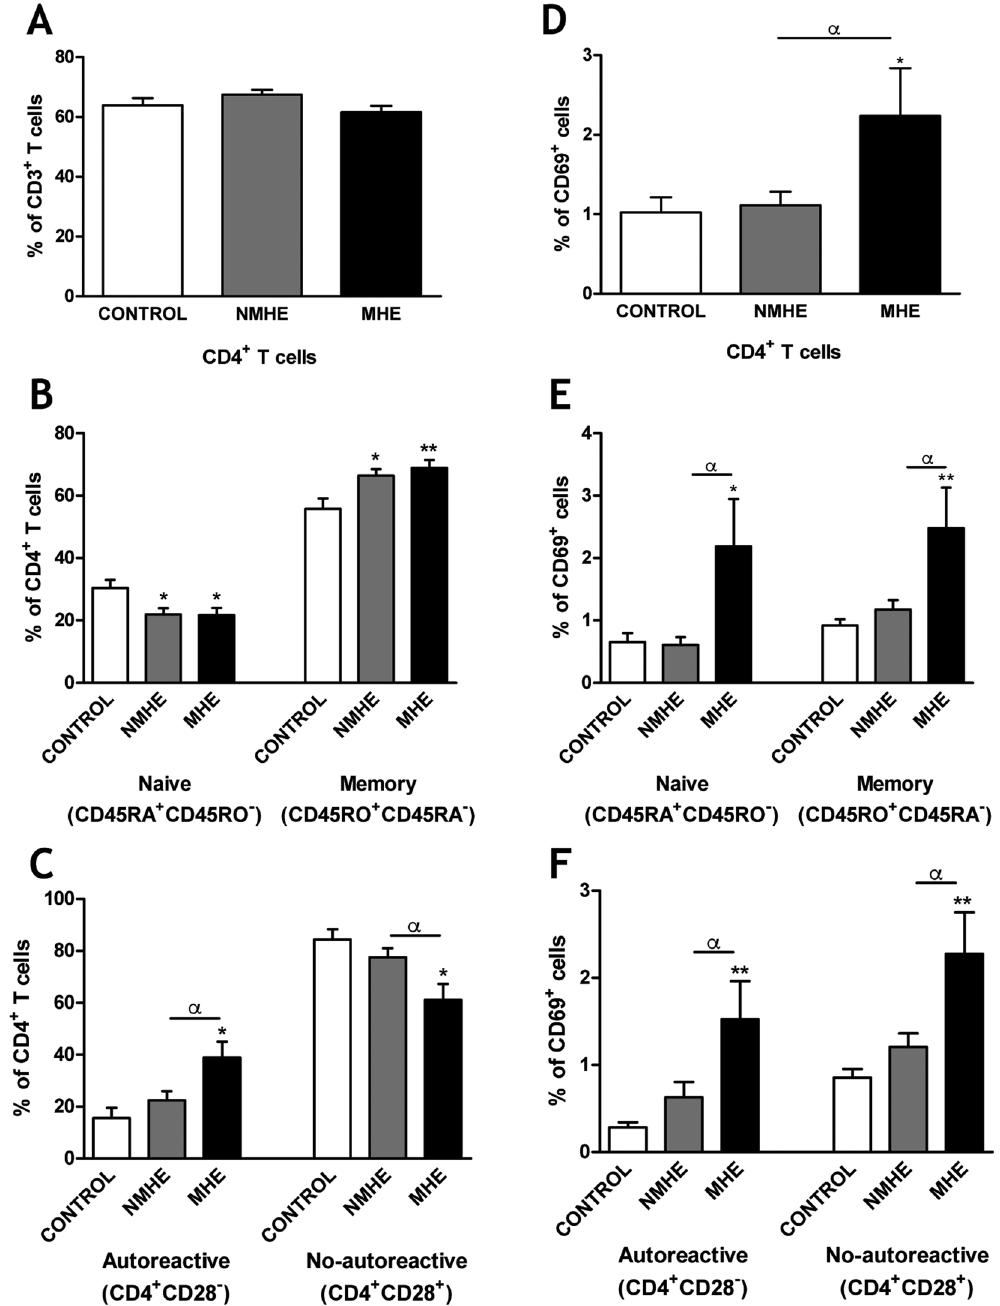
Figure 2. MHE is associated with expansion of autoreactive CD4 + CD28 − T lymphocytes and induction of the early activation marker CD69 in CD4 + T lymphocytes in peripheral blood. ( A ) Percentage of total lymphocytes that are CD4 + T lymphocytes. ( B ) Percentage of CD4 + T lymphocytes that are naive or memory. ( C ) Percentage of CD4 + T lymphocytes that are autoreactive (CD4 + CD28 − ) or not autoreactive (CD4 + CD28 + ). ( D–F ) show that percentage of total CD4 + T lymphocytes ( D ), naive or memory CD4 + T lymphocytes ( E ), and autoreactive or not autoreactive CD4 + T lymphocytes ( F ) that express CD69. Values are the mean ± SEM of the following number of individuals: CONTROL n = 23; without MHE (NMHE) n = 30 and with MHE (MHE) n = 28. Values significantly different from controls are indicated by asterisks * . Values significantly different in patients with MHE compared to NMHE are indicated by α . ( * / α p < 0.05; ** p <